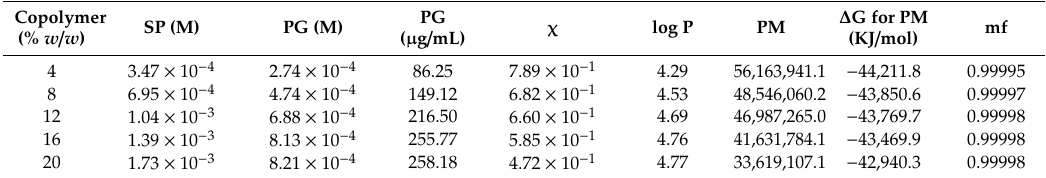
Table 2. PG solubilization capacity of Soluplus dispersions in a PBS pH 7.4, calculated using